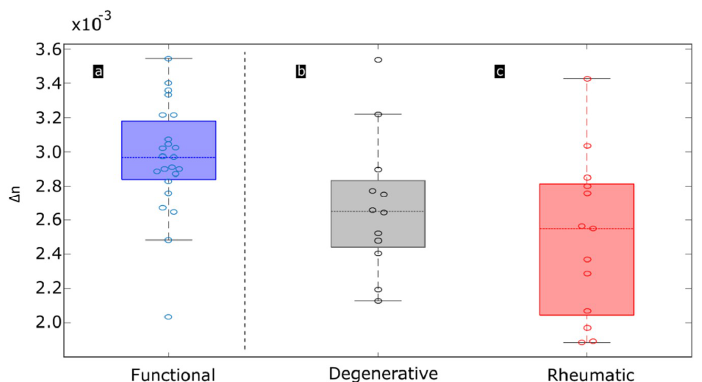
Figure 7. Boxplots representing birefringence of each of the three categories analyzed: functional CTs (blue), degenerative CTs (grey), rheumatic CTs (red). Circles represent observations. Black dashed line represents separation between healthy and pathological categories.